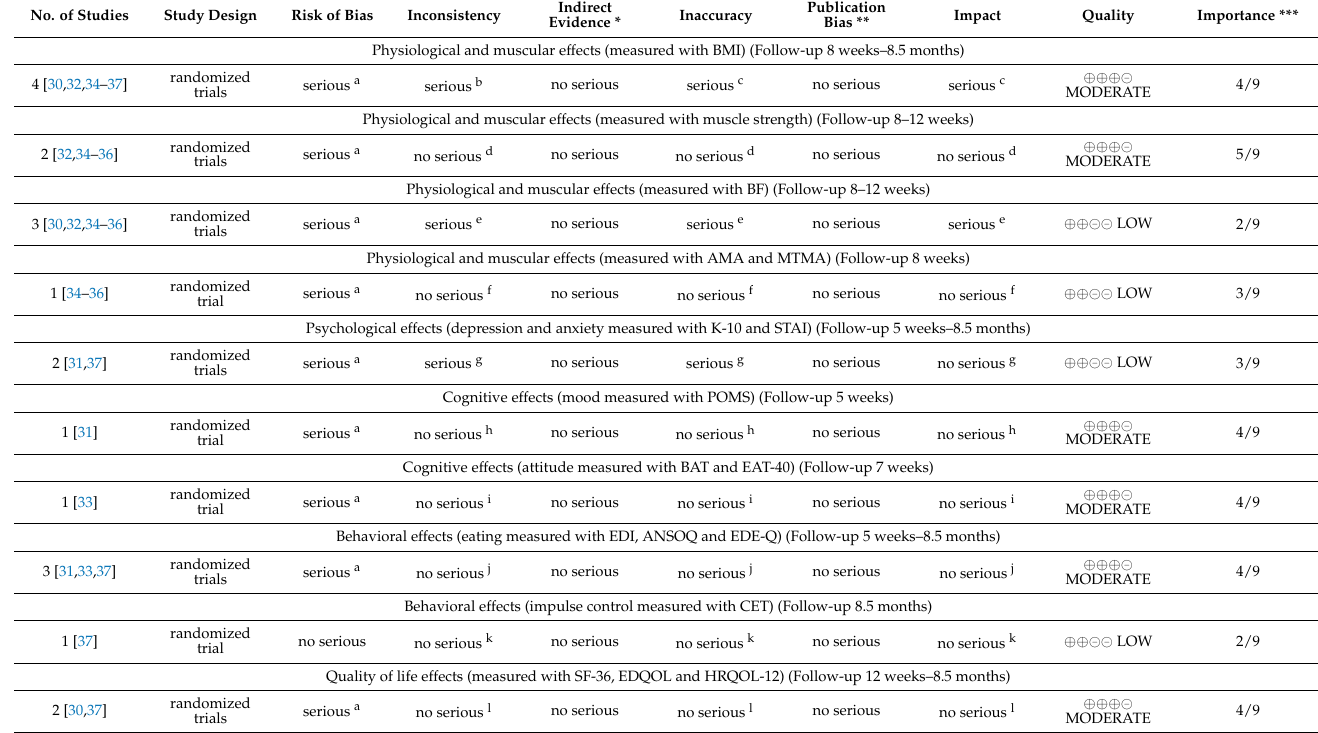
Table 3. Quality of evidence GRADE of included studies